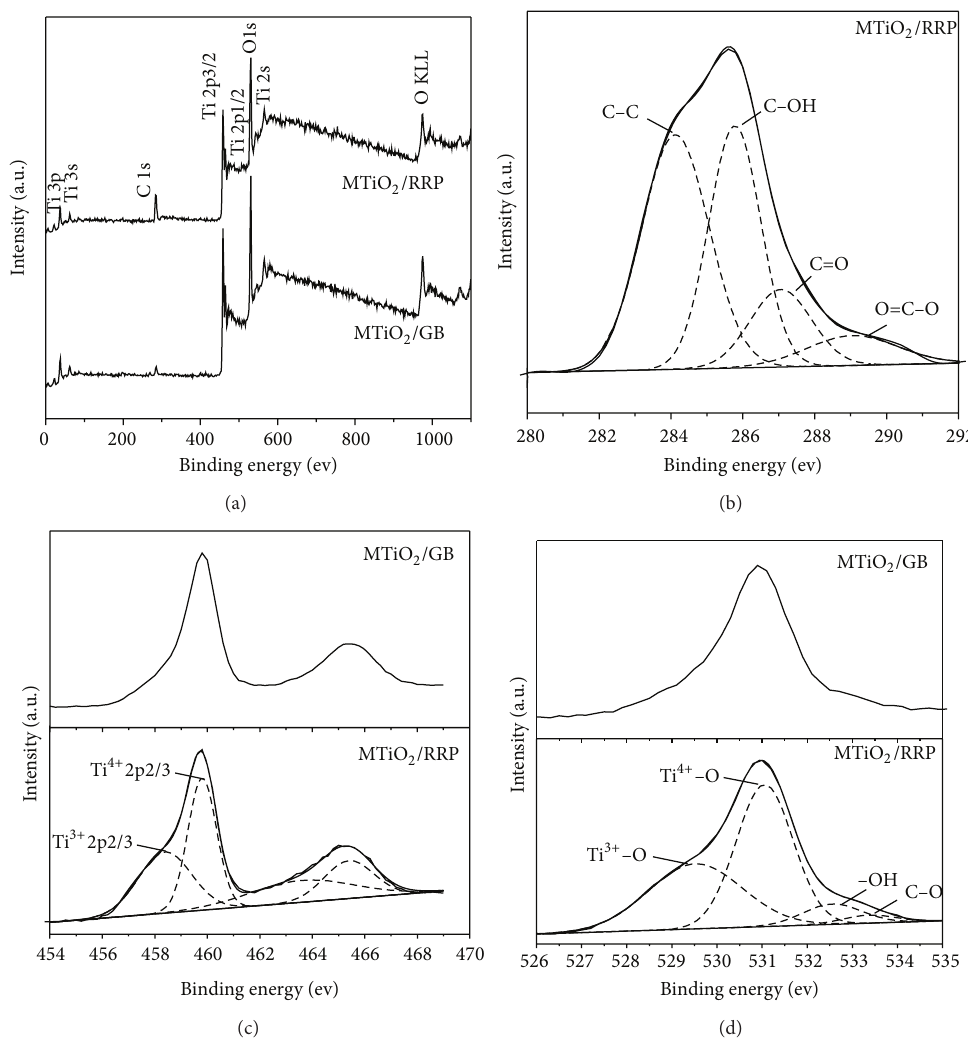
Figure 8: XPS survey spectrum of MTiO 2 (a) and corresponding C 1s (b), Ti 2p (c), and O 1s (d) high-resolution XPS spectra.